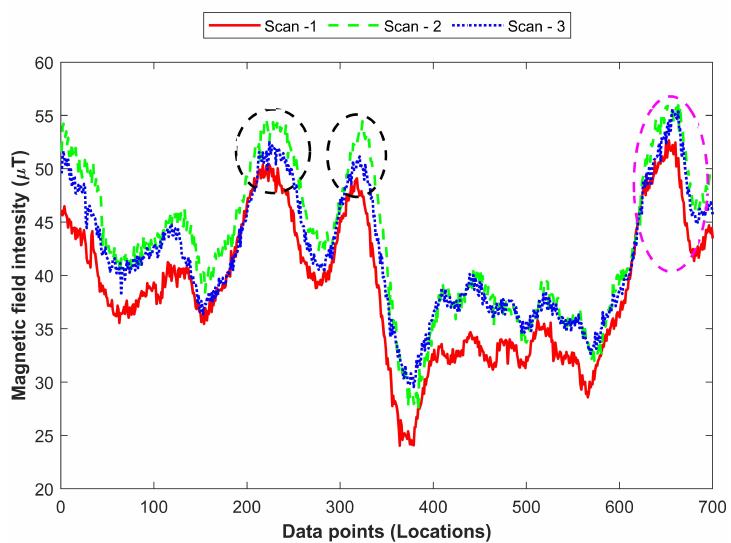
Figure 7. Time related mutation of the magnetic field data. The circled portions of the figure highlight the points with abnormal changes.